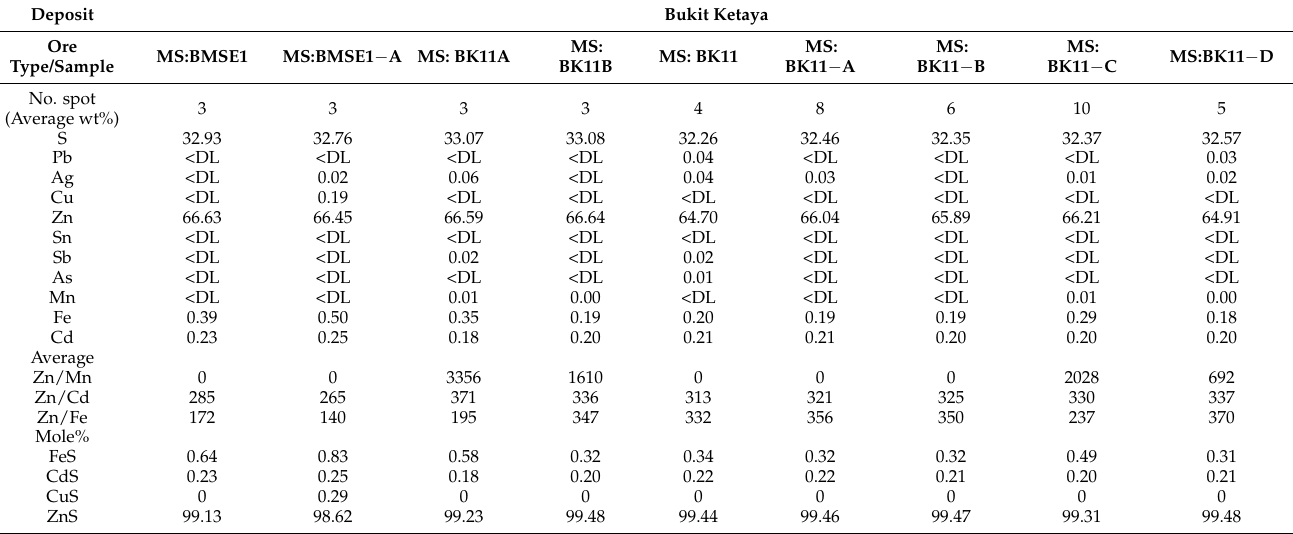
Table 3. Average chemical compositions of the representative sphalerite in a massive sulphide layer from the Bukit Ketaya deposit, Central Peninsular